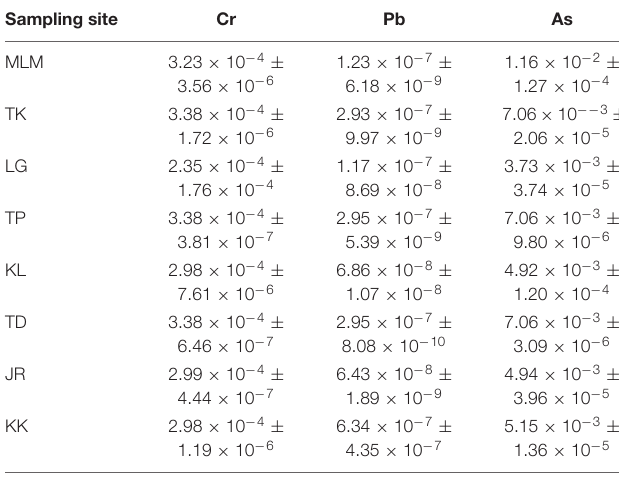
TABLE 6 | Target cancer risk (TR) of elements via the consumption of giant mudskippers collected from the West Coast of Peninsular Malaysia. Sampling